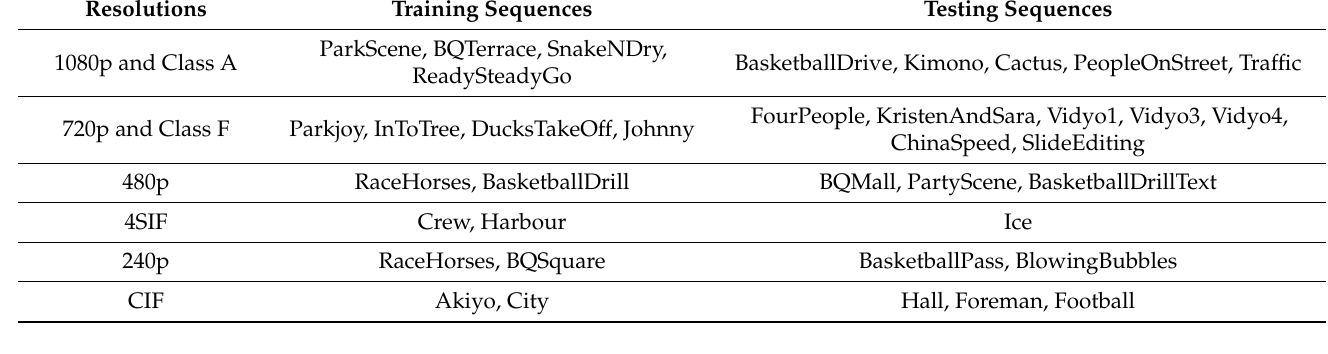
Table 1. Training and testing sequences at various resolutions and frame rates.